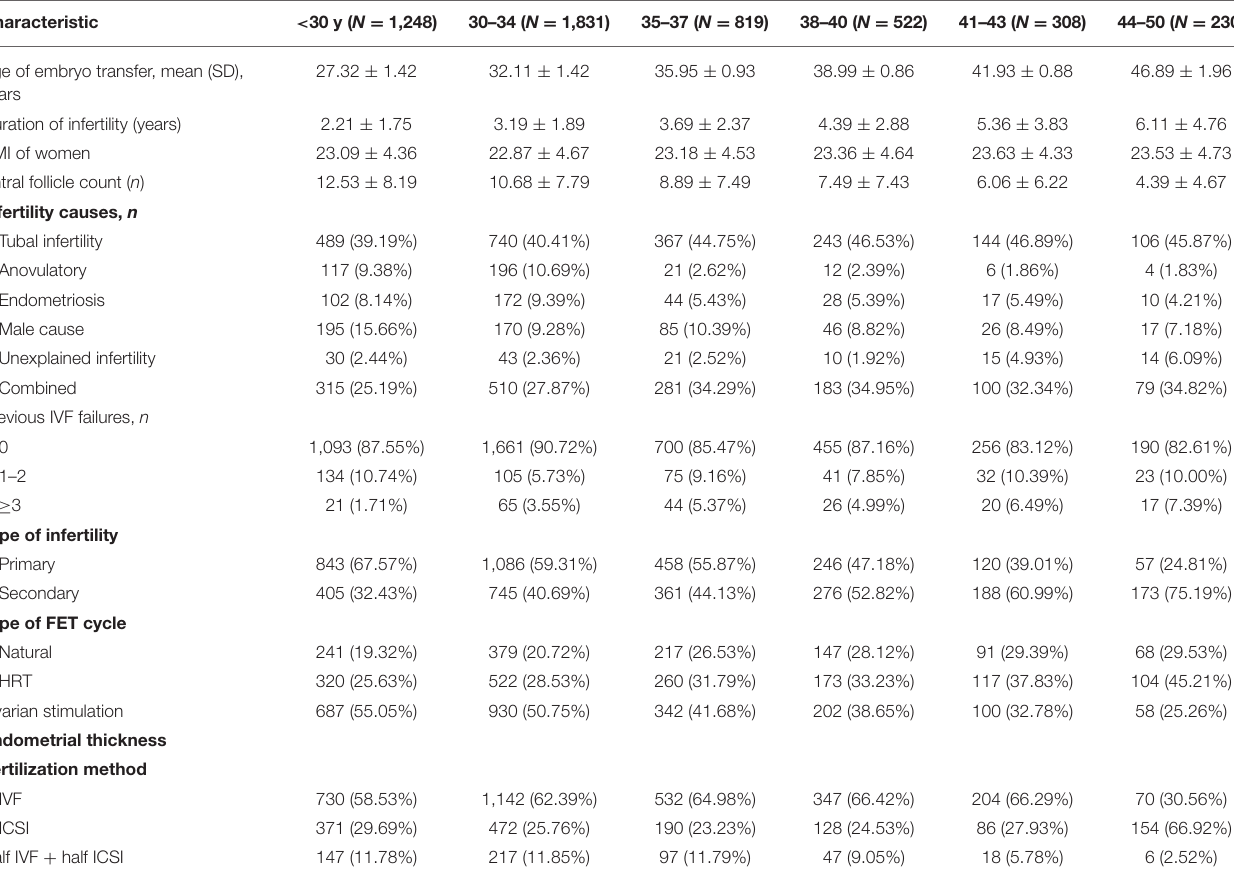
TABLE 1 | Baseline characteristics of all FET